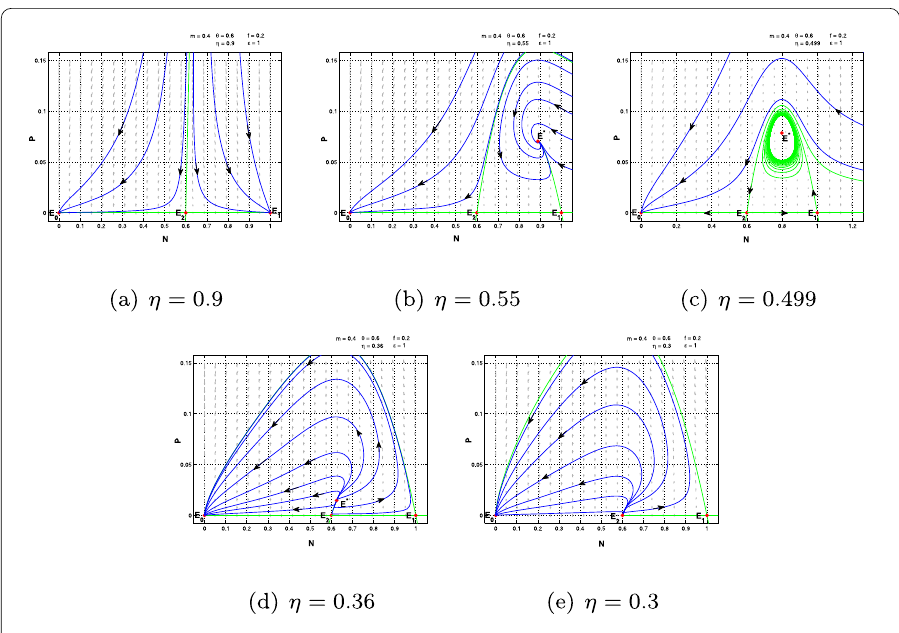
Figure 4 Dynamic behavior of the system (5) with θ = 0.6, ε = 1, f = 0.2, m =